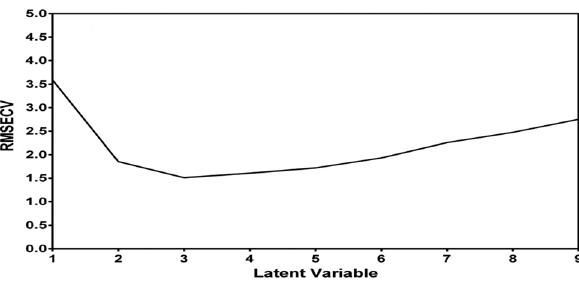
Figure 3: The optimum number of latent variables of AZM, CHT, and AZ for PCR and PLS models.